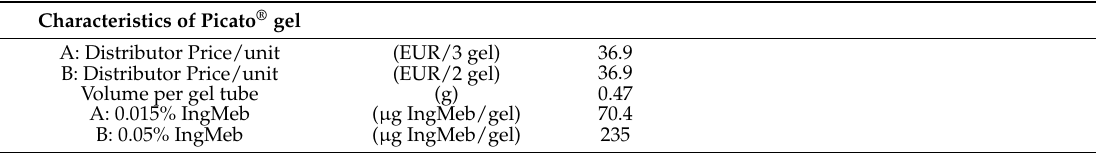
Table 8. Production cost of pharmaceutical ingenol-mebutate from Euphorbia peplus according to the market characteristics of Picato ® gel and the cultivation yields. The cultivation and extraction yields generated output, capex, and opex. Three scenarios according to the type of Picato ® gel produced (0.015%, 0.05%, and a mix of the two items) were simulated. The return on investment was calculated according to the scenarios and to the annual biomass generated by cultivation in the R&D and R&D+ containers under two light intensities. A simulation with the best annual biomass multiplied by 10 (meaning running 10 shipping containers) is also presented. IngMeb: